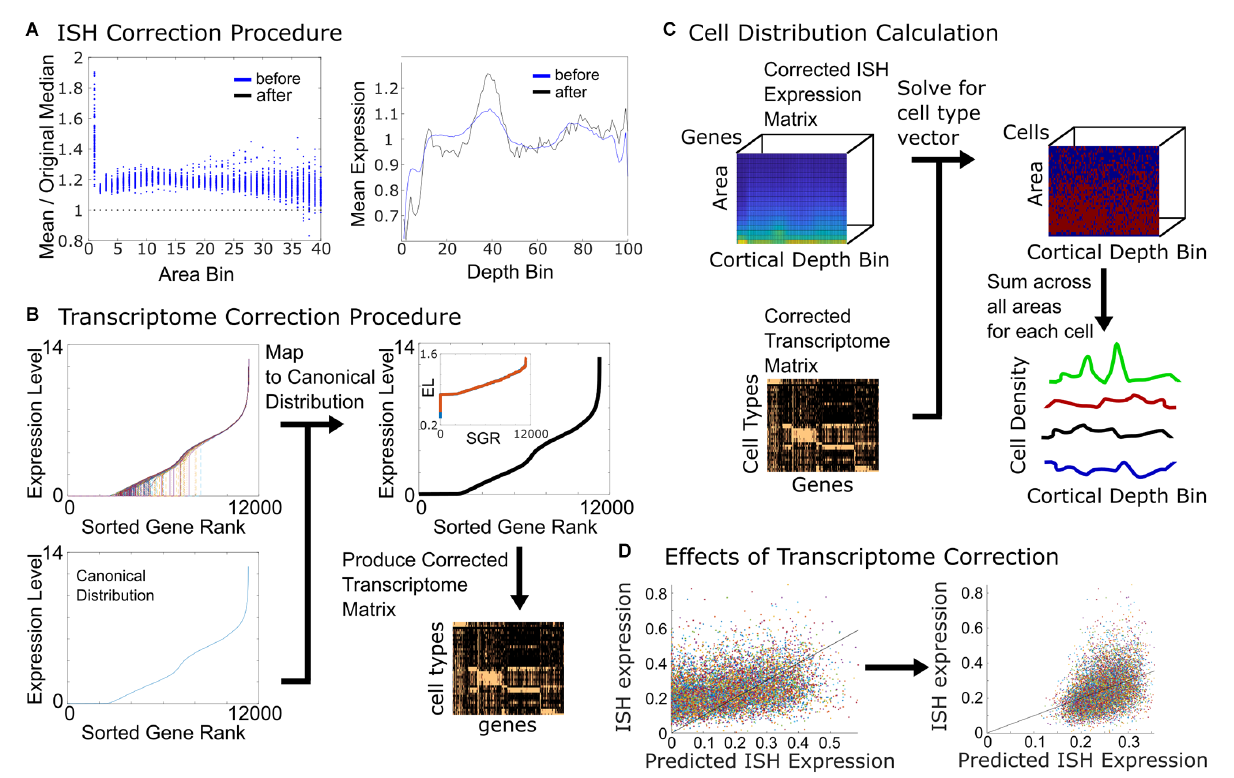
FIGURE2 Correction procedures and cell density calculation. (A) Correction of image expression intensities is done on each bin by dividing intensity densities by the median of the expression, for all non-zero gene entries (left panel). Points in each area-depth bin before (blue) and after (black) normalization. In the right panel, the profile of the mean ISH expression as a function of cortical depth (blue) is also scaled to match the Nissl density profile (the black trace shows mean expression after rescaling). (B) Correction of cell-type transcriptomes. Plotting the sorted transcriptomes for each of the cell types (different colors) shows that they have different profiles and degrees of completeness. We wish to map them to the same canonical distribution (lower left panel, blue line). After mapping, all sorted transcriptomes have the same shape (black trace, upper right panel). The inset shows the final expression level vs. sorted gene rank, starting from two different seeds (red and blue). They converge to the same distribution. Adjusted transcriptomes are used to generate a corrected transcriptome matrix. (C) The corrected expression and transcriptome matrices are used to solve for the cell density in each area-depth bin. By summing across the area bins a cell density vector as a function of depth is produced for every cell type. (D) If an uncorrected transcriptome is used, the predicted ISH expression deviates substantially from the actual ISH expression (left panel). After optimization, the predicted vs. actual expressions better correspond (right panel). A line with unity slope is shown for